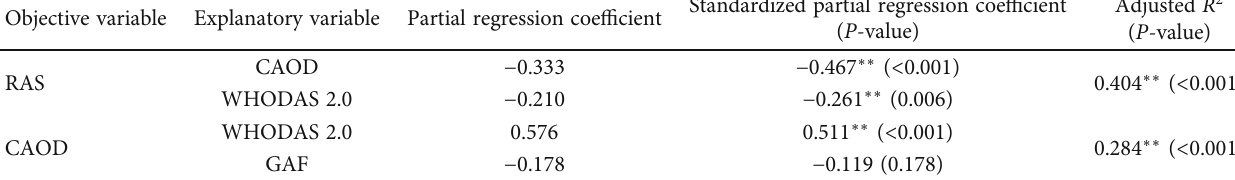
Table 4: Causal relationships between